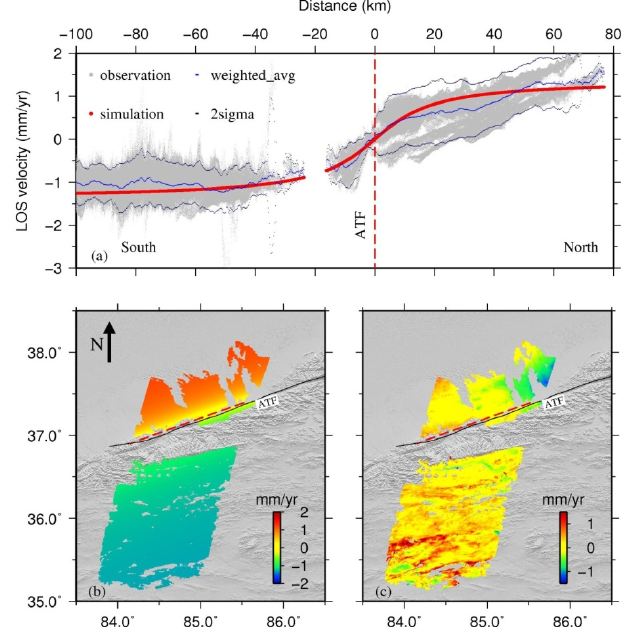
Figure 8. ( a ) D391 mean LOS velocity profiles (gray dots) and the weighted average profile (dark blue) with 2 σ deviation (light blue). All of the points shown on the left are projected onto the profile as gray dots. The red line is the best-fit model with a slip rate of 8.0 mm/year and 14.5 km locking depth; ( b ) Model simulation map from the best-fit model values. The fat black arrow shows the north direction; ( c ) Residuals between model and observation results. The near zero residuals demonstrate the inversion goodness.